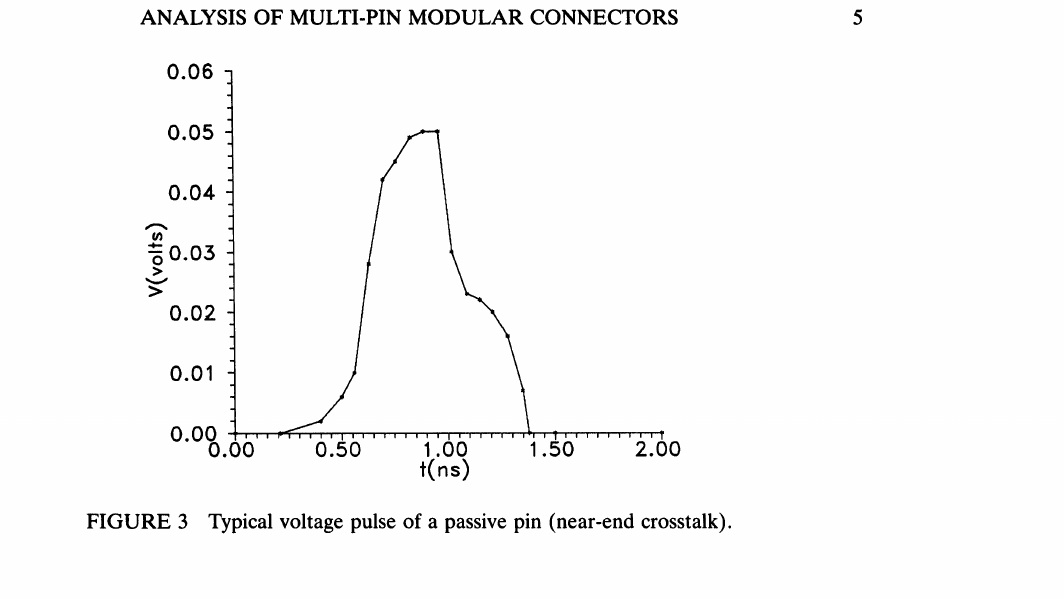
FIGURE 3 Typical voltage pulse of a passive pin (near-end crosstalk).